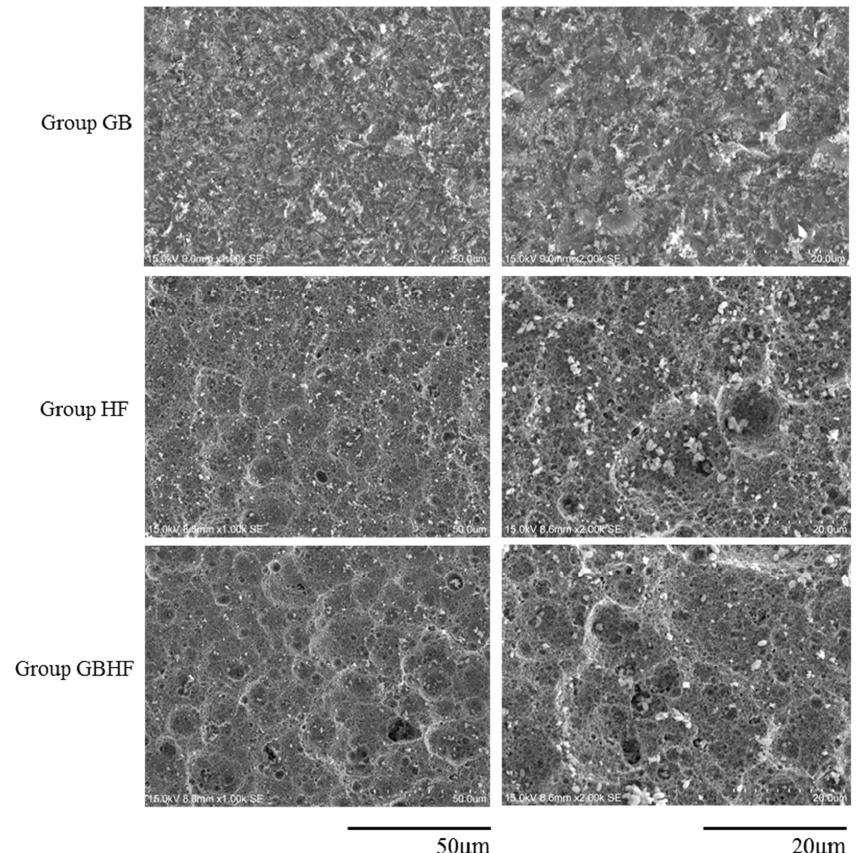
Figure 1. SEM images of various zirconia surfaces at the magnification of 1000× and 2000×.